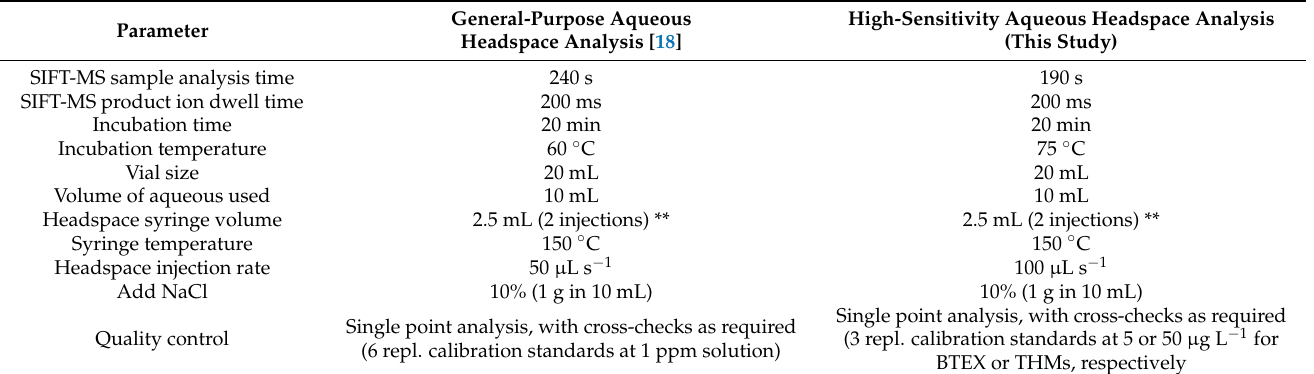
Table 3. Optimized parameters for enhanced sensitivity in headspace-SIFT-MS analysis of water compared with those for generic analysis of the same matrix [18]